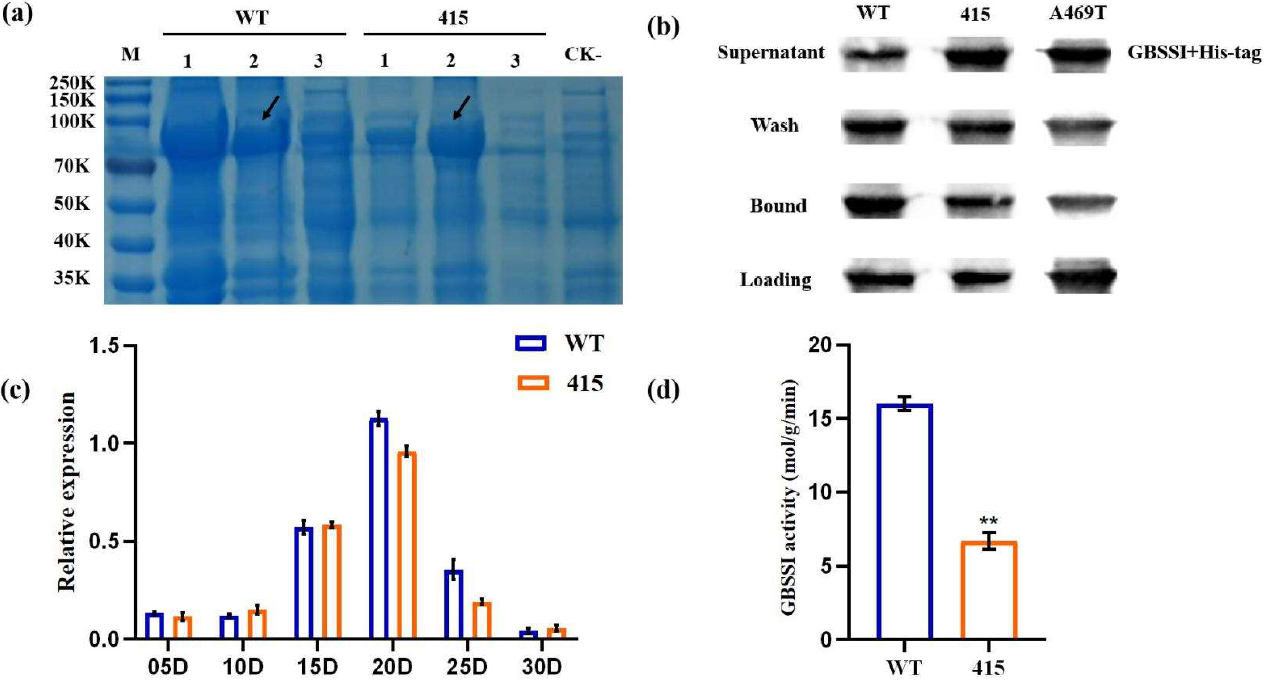
Figure 3. Expression of GBSSI protein and binding ability of mutated recombinant GBSSI to raw starch and analysis of the GBSSI enzyme activity and expression levels of wheat Wx-B1 .( a ) GBSSI activity was assayed 10 d after fertilization (DAF) of the endosperms. Asterisks indicate statistical significance between the WT and mutant lines, as determined using the Student’s t -test (** p < 0.01). ( b ) The expression levels for each accession in the parental WT and mutant M3-415 lines at 5–30 days after anthesis (DAA) in tetraploid wheat developing grains were calibrated as expression folds compared to those at 3 DAA. The x -axis and y -axis represent relative expression and DAA, respectively. ( c ) Expression of GBSSI protein in the supernatant to obtain the purified recombinant protein. Lanes are described as follows: (1) whole bacteria; (2) supernatant; and (3) precipitate. Black solid arrows indicate GBSSI protein in the supernatant. ( d ) Ability of mutated recombinant GBSSI to bind to raw starch. Corn starch was incubated with purified recombinant GBSSIs. The original unbound GBSSI was designated as “supernatant.” After SDS washing and centrifugation, the supernatant was defined as “wash.” Insoluble GBSSIs were defined as “bound.” The amounts of each GBSSI loaded on the gel per treatment were equivalent.